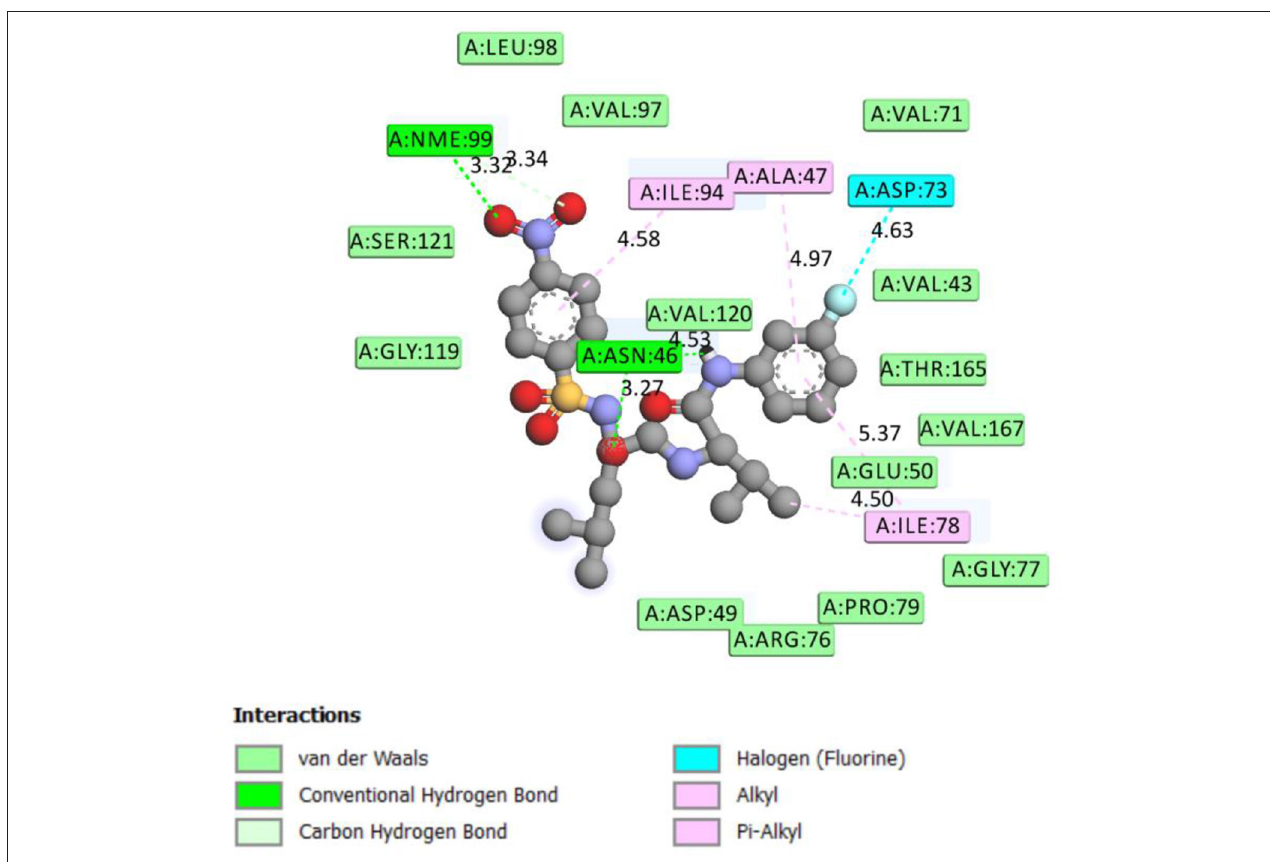
FIGURE 1 | 2D representation of binding interaction of compound 8d and the amino acid residues of 5MMN.